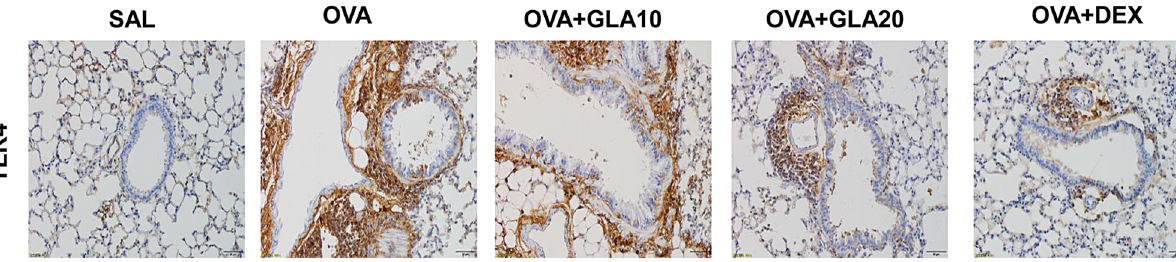
Figure 7: Immunohistochemical staining of lung tissues in asthmatic mice. Representative histological images of the lung tissues in the SAL, OVA - sensitized, Dex ( 1 mg/kg ) , and 10 and 20 mg/kg GLA groups ( 200 ×)